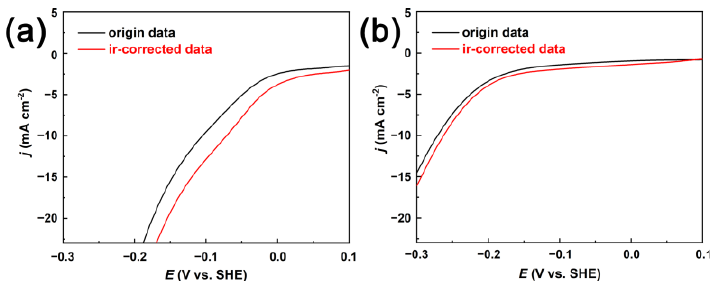
Figure 6. Polarization curves recorded in N 2 -saturated 1 M KOH electrolyte for porous ( a ) and fully dense ( b ) CuNi films. Scan rate: 50 mV s − 1